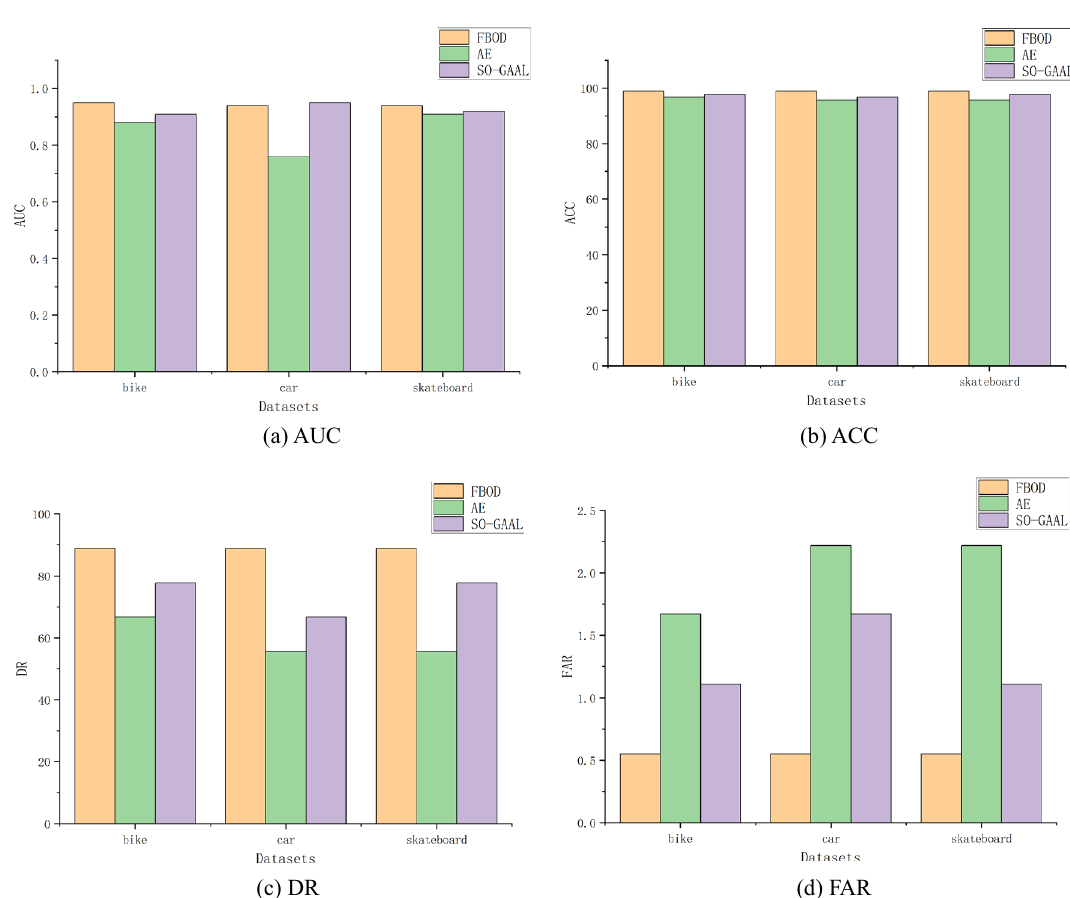
Figure 9. Experimental results of the three algorithms on video